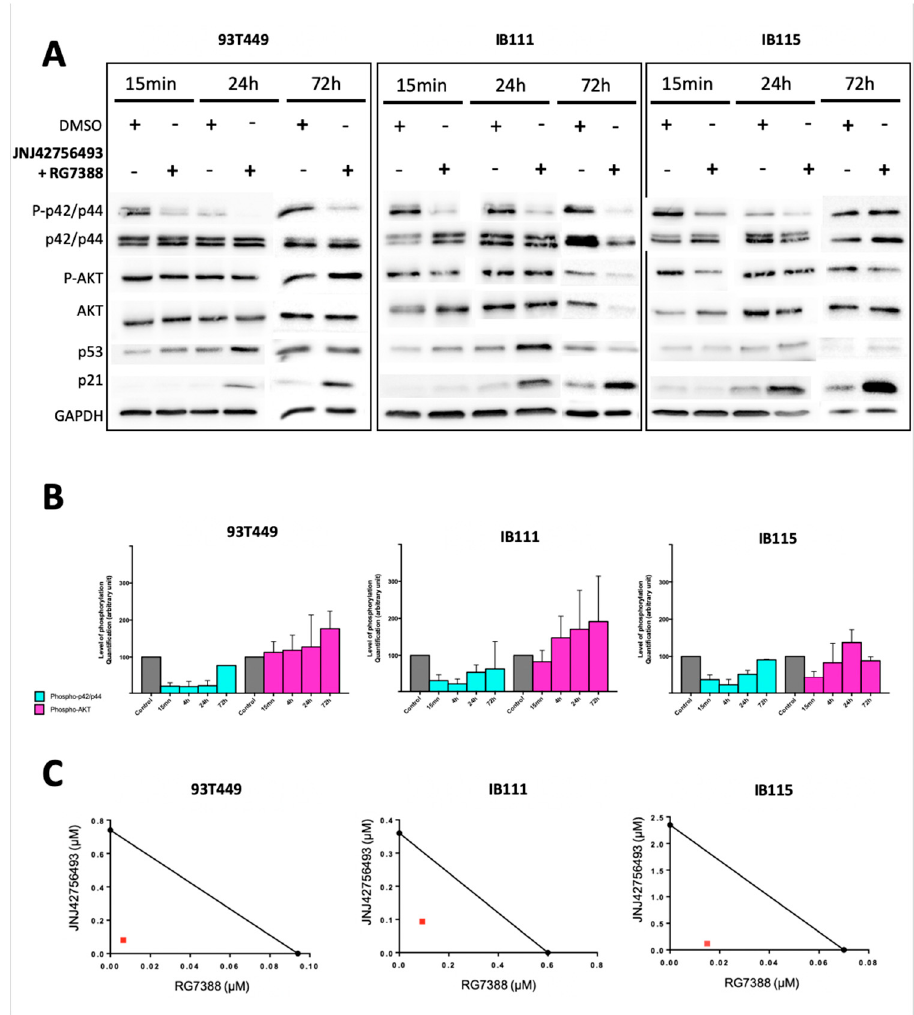
Figure 4. Effects of RG7388 in combination with JNJ42756493 on activation of the downstream signaling pathways. ( A ) Western blot analysis showing the level of phosphorylated and total protein for the indicated proteins in 93T449, IB111 and IB115 cells treated for 15 min, 24 h and 72 h with JNJ42756493 at 0.36 μ M (93T449), 1 μ M (IB111), and 2 μ M (IB115) and RG7388 at 0.04 μ M (93T449), 0.2 μ M (IB111), and 0.05 μ M (IB115). ( B ) Quantification of the western blot analyses shown in ( A ) performed on cells treated with JNJ42756493 + RG7388 for 15 min, 4 h, 24 h, and 72h. ( C ) Isobologram representation for the 93T449, IB111 and IB115 cell lines. The combination index (CI) values for the JNJ42756493 + RG7388 combination were calculated and were the following: 0.18, 0.40 and 0.26 respectively, indicating synergy for both WDLPS and DDLPS cells.